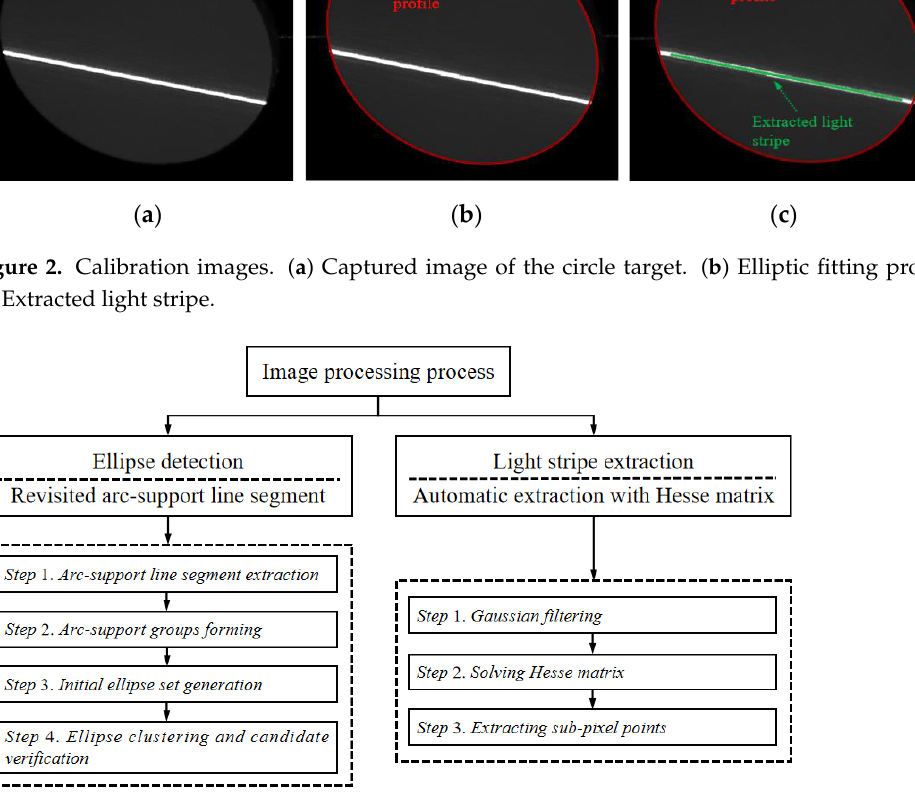
Figure 3. Flowchart of the complete image processing algorithm.